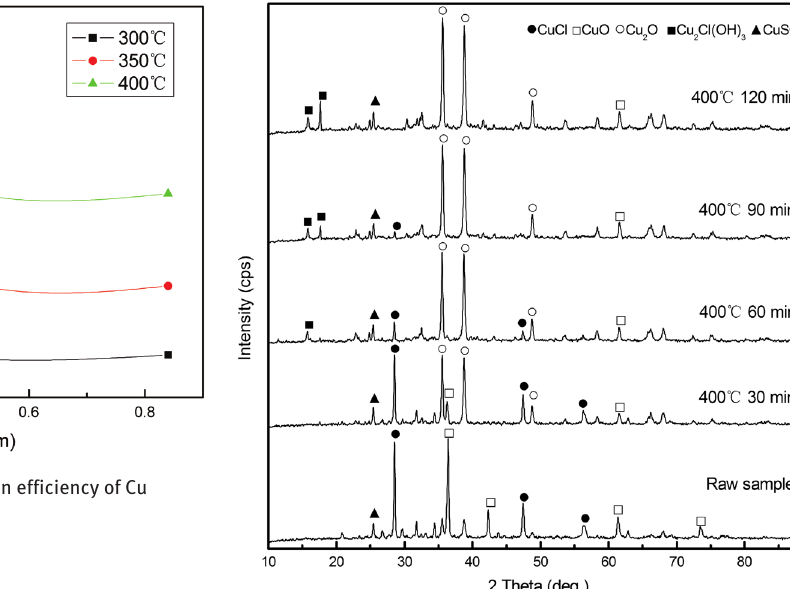
Fig. 6: X-ray diffraction pattern of raw CuCl residue and sample after microwave